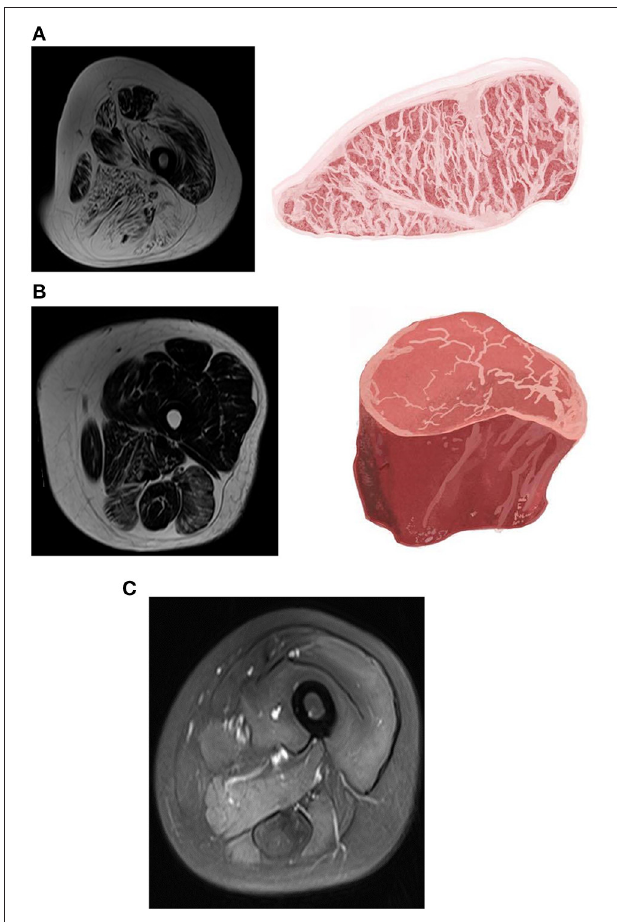
FIGURE 2 | Magnetic resonance imaging (MRI) of muscle fat substitution and edema in different grades and the illustration of Wagyu beef and filet steak. (A) T2-weighted Dixon fat-only image of a 40-year-old female with limb-girdle muscular dystrophy (LGMD). There was a high-grade fat substitution in almost all compartments of the thigh muscles, which resembled Japanese A5 Wagyu steak. The marked fatty replacement was noted in the adductor magnus, biceps femoris, semimembranosus, and semitendinosus muscles. (B) T2-weighted Dixon fat-only image of a 50-year-old female with polymyositis. Low-grade muscle fat substitution was depicted in IIM compared with LGMD, which resembles the United States Department of Agriculture Choice filet steak. (C) T2-weighted Dixon water-only image of a 24-year-old female with polymyositis. High-grade edema in the quadriceps, adductor magnus, semimembranosus, semitendinosus, and biceps